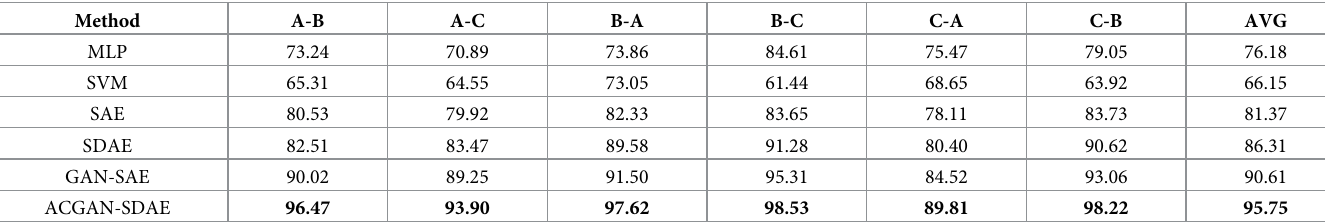
Table 5. Diagnosis accuracy of different models under across different load domains